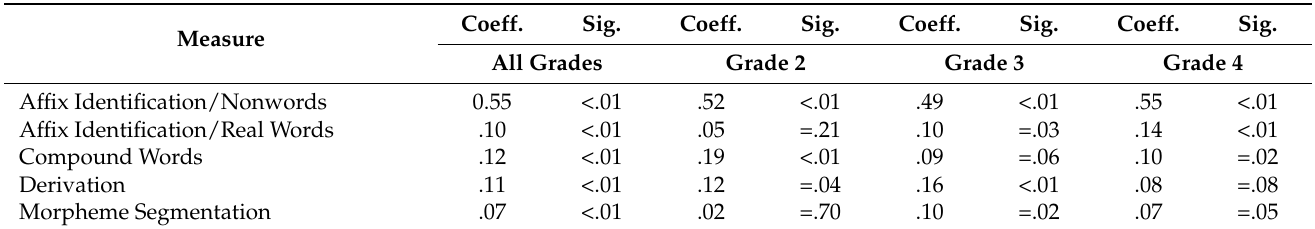
Table 8. Regression analyses on different aspects of morphological awareness and reading compre- hension on latent